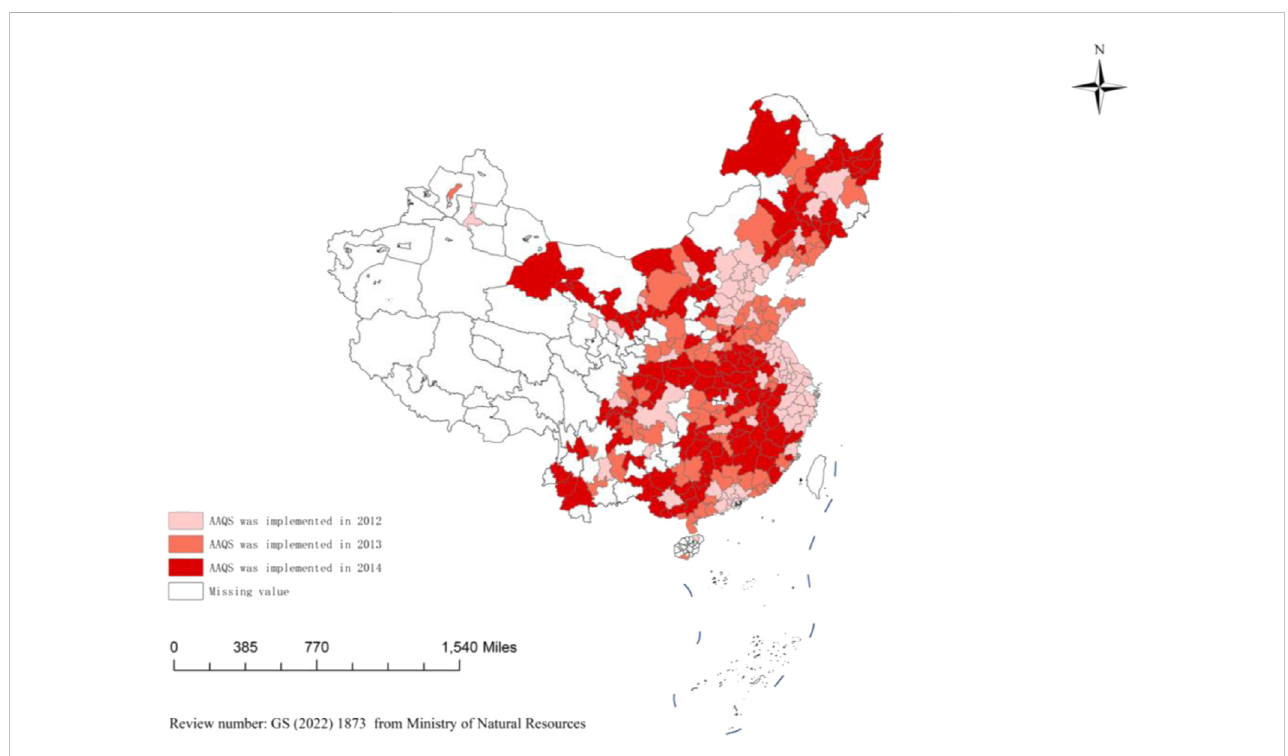
FIGURE 1 Spatial distribution of AAQS implementation